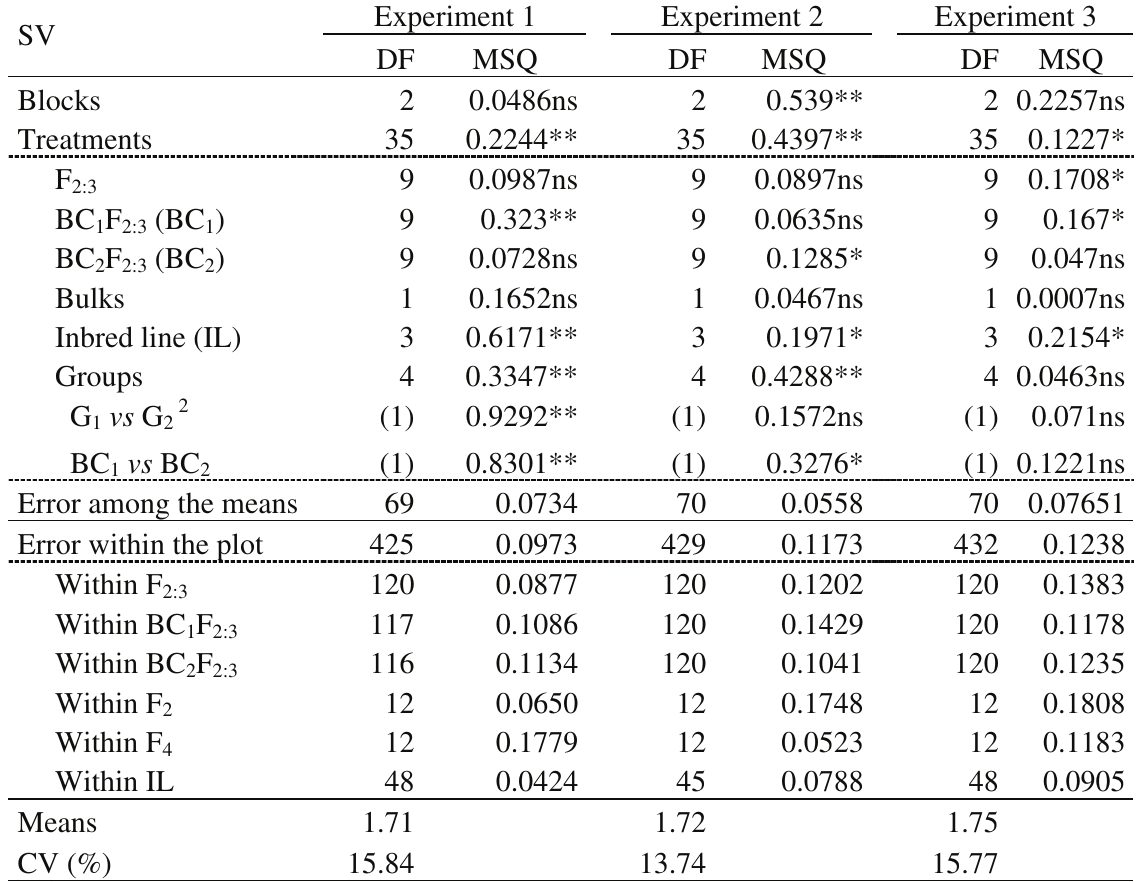
* and ** : significant at 5% and 1% of probability by F Test,